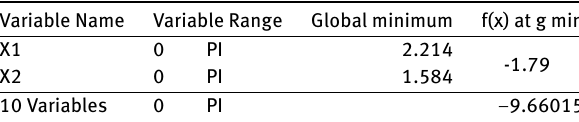
Table 4: Ranges of variables and global minimum for Michalewicz’s